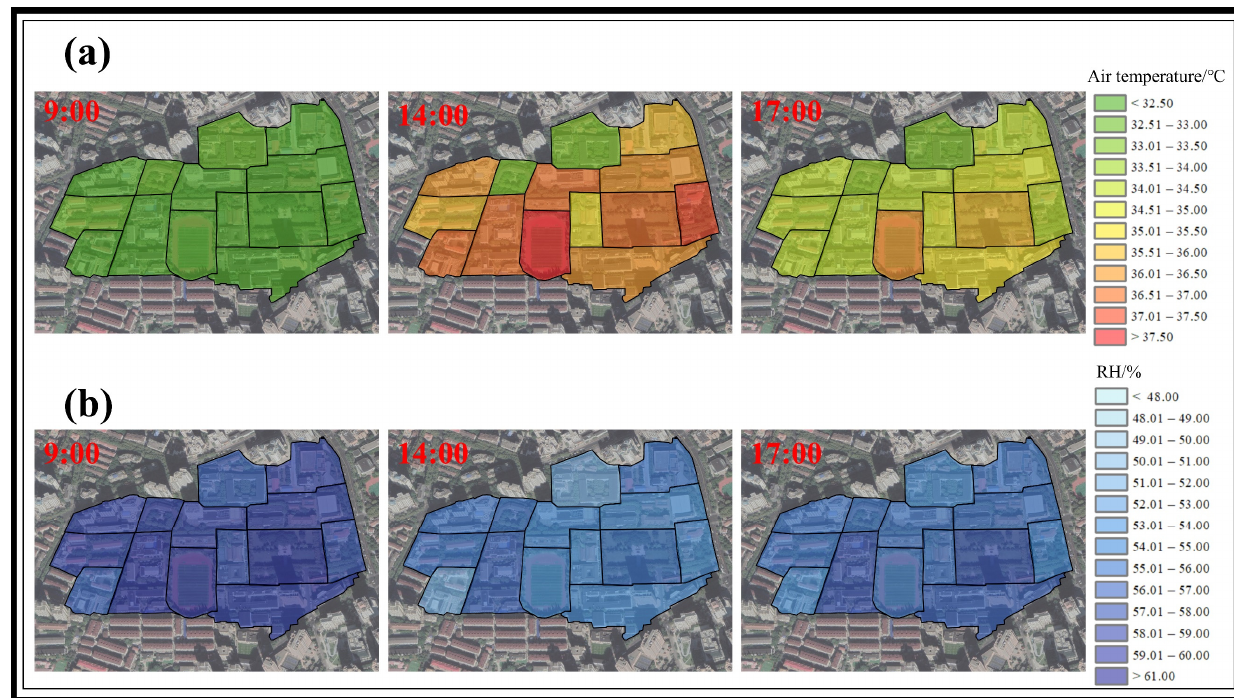
Figure 8. ( a ) The temporal and spatial distribution maps of air temperature and relative humidity at typical times in the test area. ( a ) The distribution maps of air temperature. ( b ) The distribution maps of relative humidity.